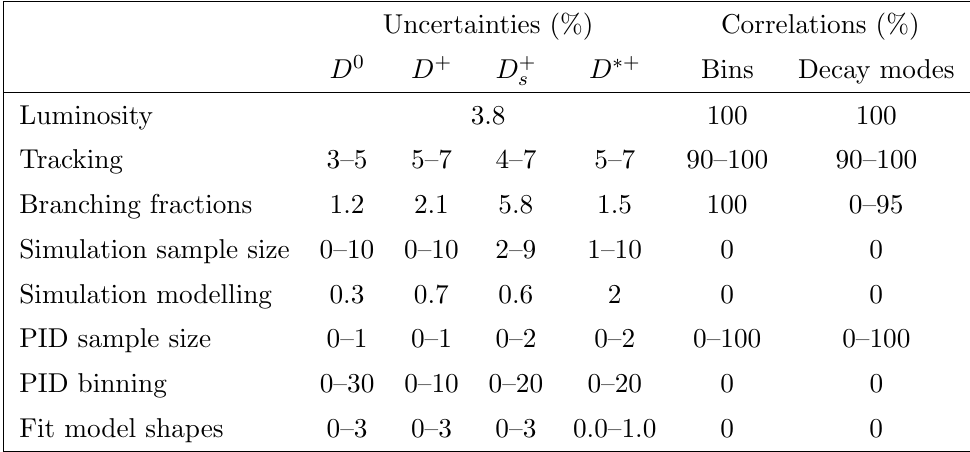
Table 2. Fractional systematic uncertainties, in percent. Uncertainties that are computed bin-by- bin are expressed as ranges giving the minimum to maximum values. Ranges for the correlations between p T - y bins and between modes are also given, expressed in